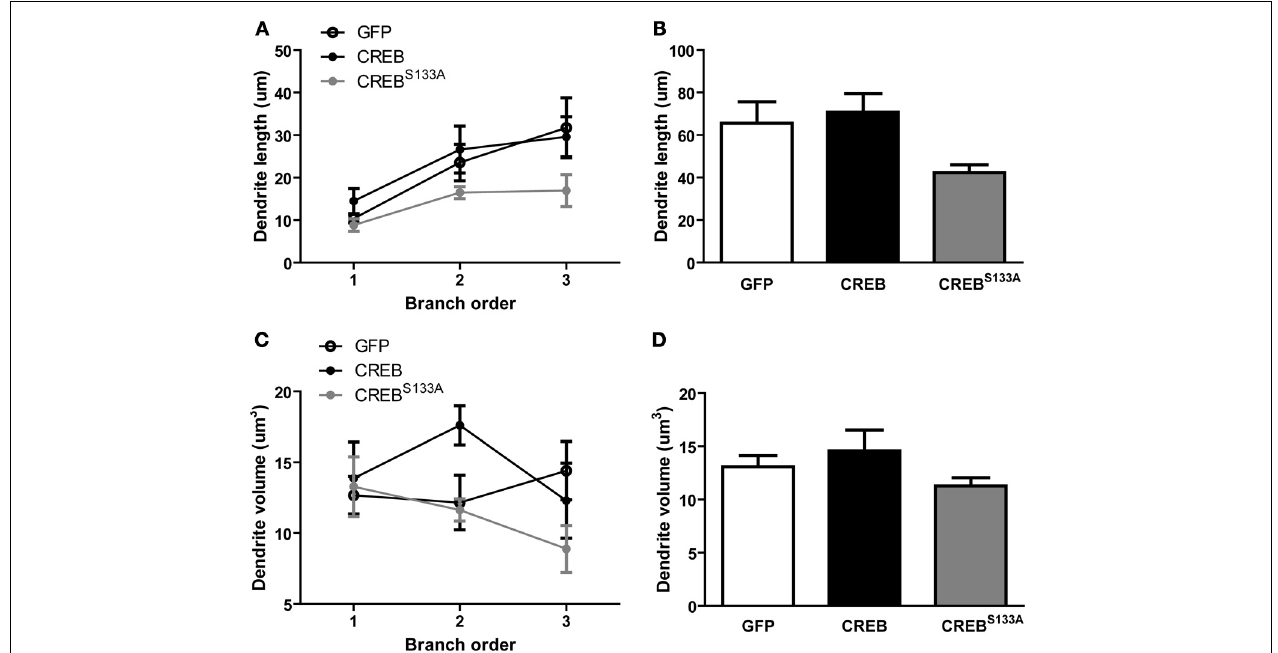
CREB S133A ( n = 5) vectors. (C) Dendrite volume per branch order and (D) across all branches did not differ between LA neurons overexpressing GFP